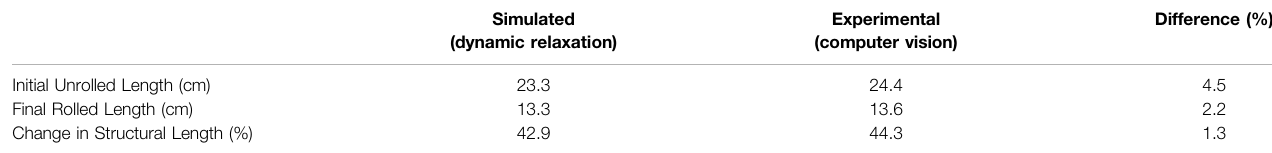
TABLE 3 | Comparison of the percentage change in length of the OPB structure between the simulated and the experimental results.